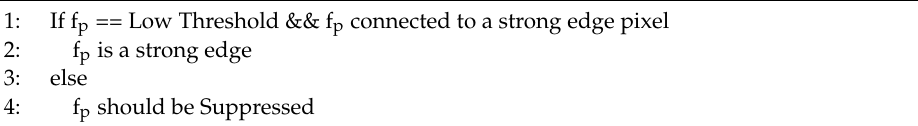
Algorithm 2 : Suppress Isolated Low Threshold Points